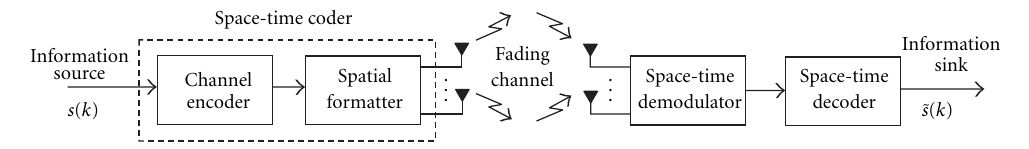
Figure 1: Space-time coding and decoding